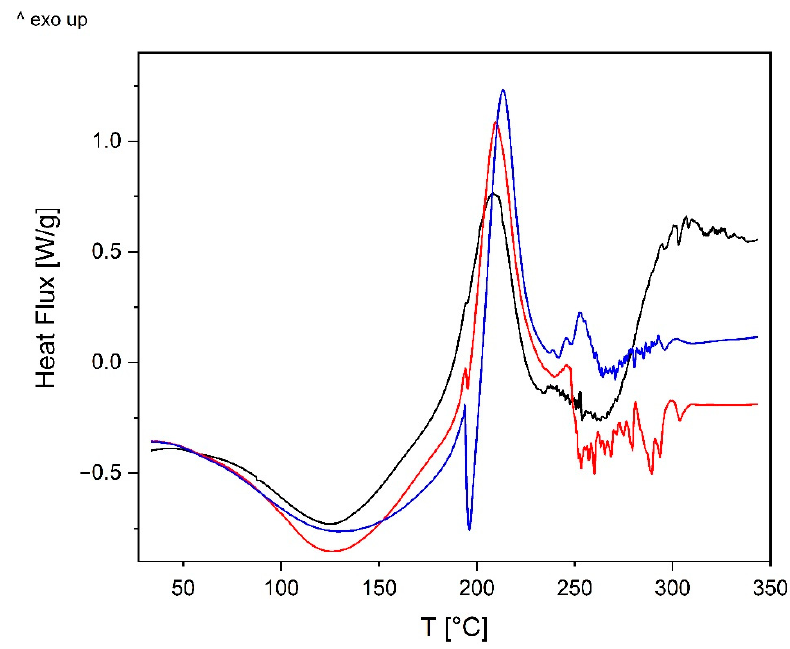
Figure 6. DSC chart in argon: ALG (black line), ALG/Ag/GOX (blue line), ALG/Au/GOX (red line).